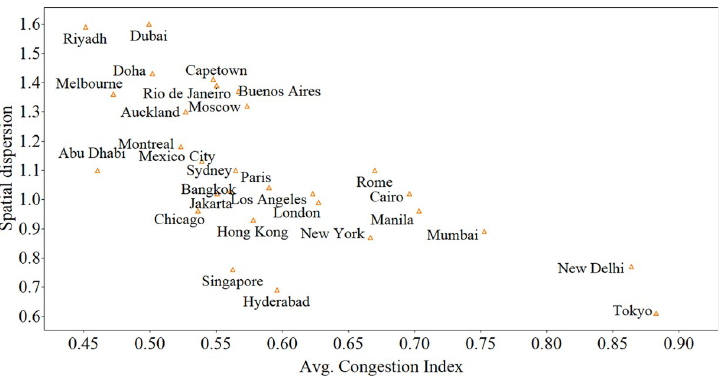
Fig 7. Rate of spatial dispersion of various cities plotted against the average CI of the city.